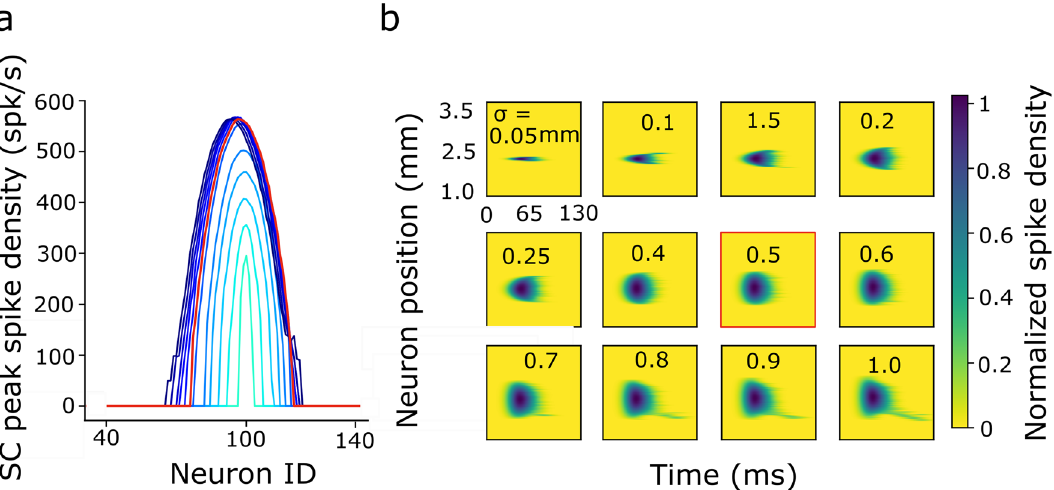
Figure 6. Burst profiles of the neurons in the network with lateral intra-collicular connections in response to the external input current that induces different input population sizes around T = 15 deg. ( a ) Peak firing rates of the SC neural population. Red curve is the response to the default input current with σ pop = 0.5 mm. The population grows with input size up to the default current for low input strengths (light blue), after which it remains approximately invariant (dark blue). ( b ) Firing rate distributions of the neural population in the motor map as function of time, normalized to the absolute firing rate of the central cell (550 spks/s). Each panel shows the result for a specific input population size (indicated in mm). Red outlined panel corresponds to the default stimulation condition (0.5 mm). Panels preceding the default show that the SC population grows with the input population; panels following the default show that the number of active neurons remains approximately constant, even though the input population size grows to the double size.